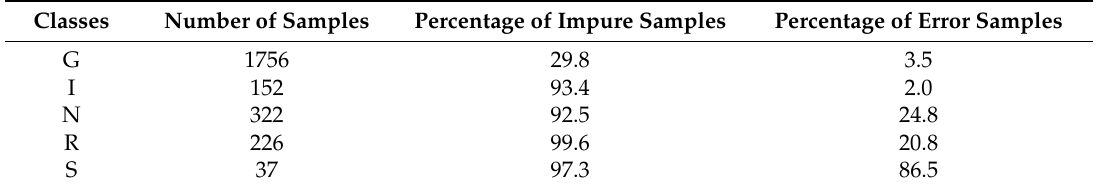
Table 4. Results of sample fuzzification.